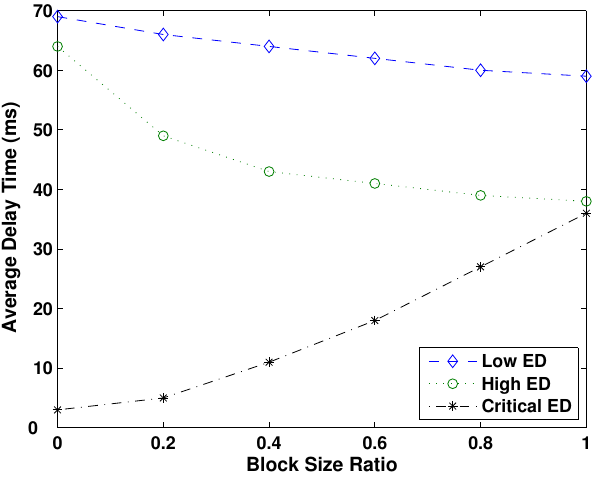
Figure 4. Average delay time as a function of the block size ratio, over P and Critical ED nodes present a similar performance at BSR = 1